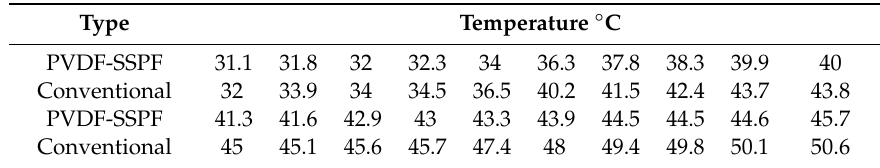
Figure 8. Heatmap analysis showing the correlations and thermal performance of ( a , b ) surface temperature of the developed module and backsheet temperature of the developed module in a simultaneous test; ( c , d ) PVDF-SSPF backsheet temperature and conventional backsheet temperature under similar weather condition test. Table 2. A summary of thermal readings based on temperature ( ◦ C) of PVDF-SSPF and conventional